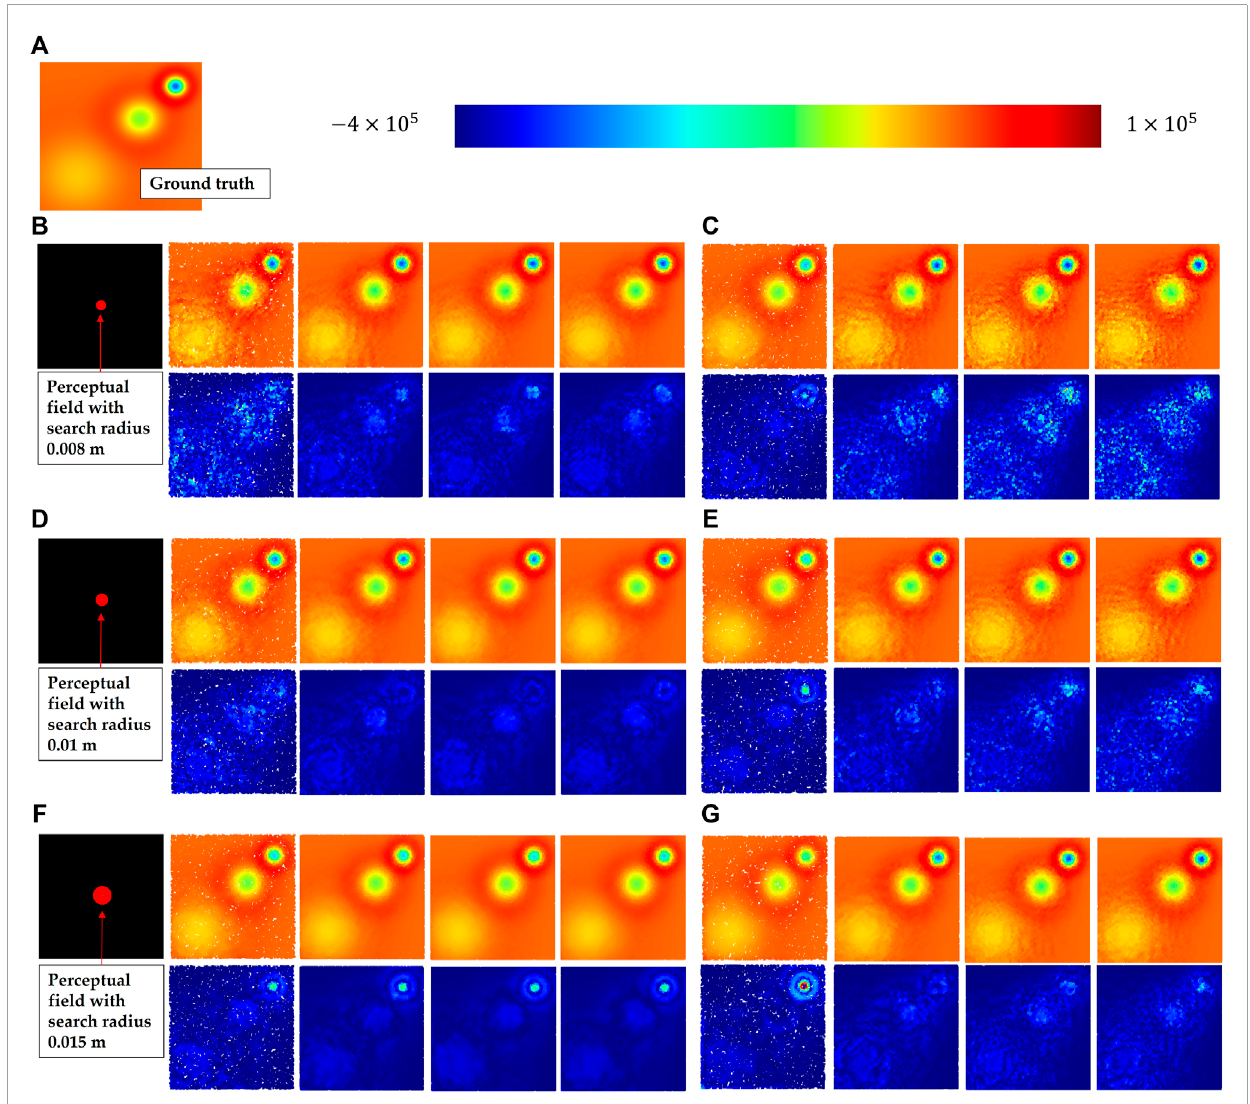
FIGURE 7 These figures show the results of the experiment to evaluate the accuracy of divergence solution. (A) Shows the ground truth of the divergence distribution; then, the results (top) and errors (bottom) using RNN with search radius (top to bottom: 0.008 m (B) , 0.01 m (D) and 0.015 m (F) ) are presented; finally, the results using KNN with number of neighbors (top to bottom: 200 (C) , 300 (E) and 500 (G) ) are presented. Each subfigure also shows the results with various same downsampling rates (left to right: 0.1, 0.4, 0.7,